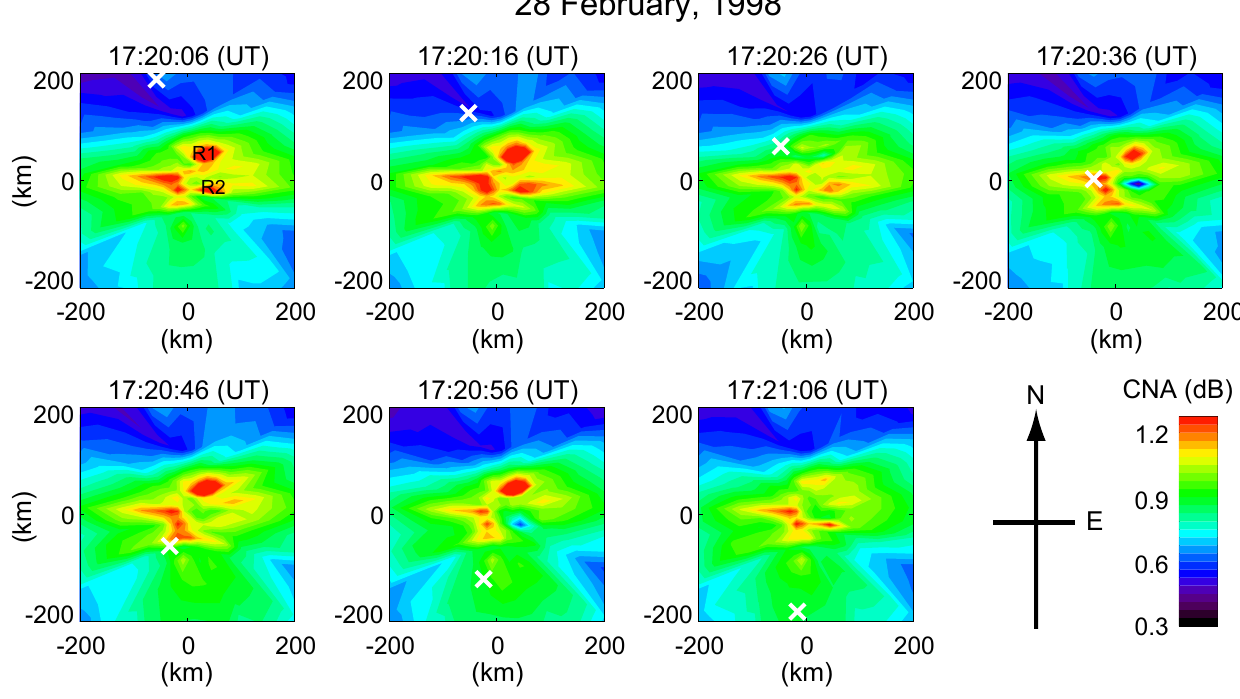
Fig. 1. CNA event observed during 17:20:06–17:21:08 UT on 28 February 1998. The magnetic north and east correspond to the top and right, respectively, as one sees the ionosphere from above. The white cross shows the footprint of NOAA 12 at 90km and the scintillations labeled by the letters, R 1 and R 2 , are radio stars, Cassiopeia-A and Cygnus-A, respectively.